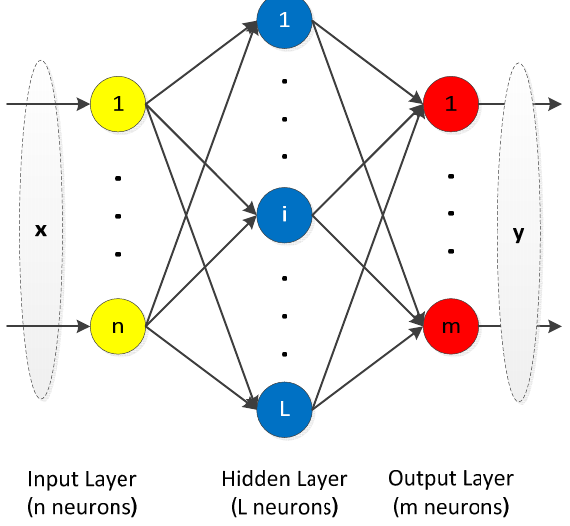
Figure 2. Structure of single layer feedforward network.